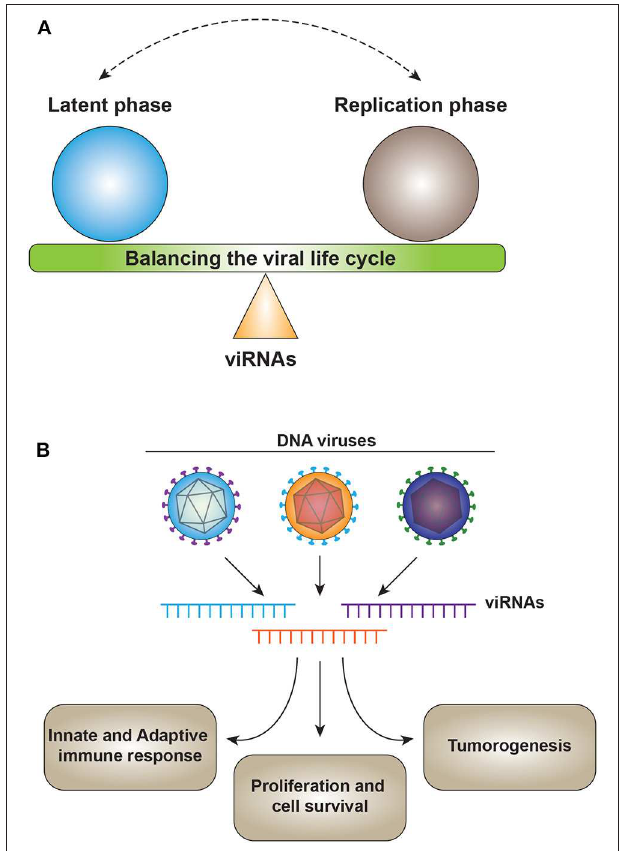
FIGURE 2 | (A) v-miRNAs act as a fine switch between latency and the active replication phase of the viral lifecycle. (B) v-miRNAs control the